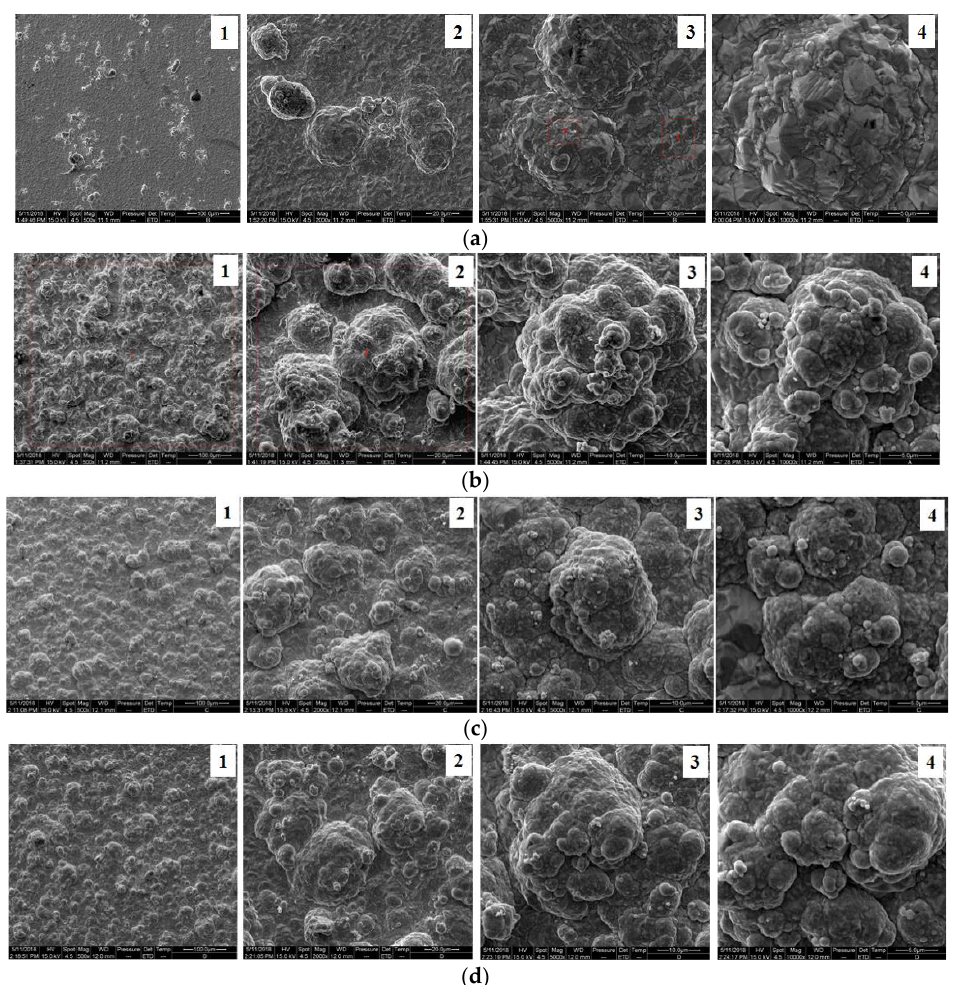
Figure 5. Scanned images of composite plating at four different magnifications (1 × 500, 2 × 2000, 3 × 5000, 4 × 10,000): ( a )1 g/L, ( b ) 5 g/L, ( c ) 10 g/L and ( d ) 15 g/L.